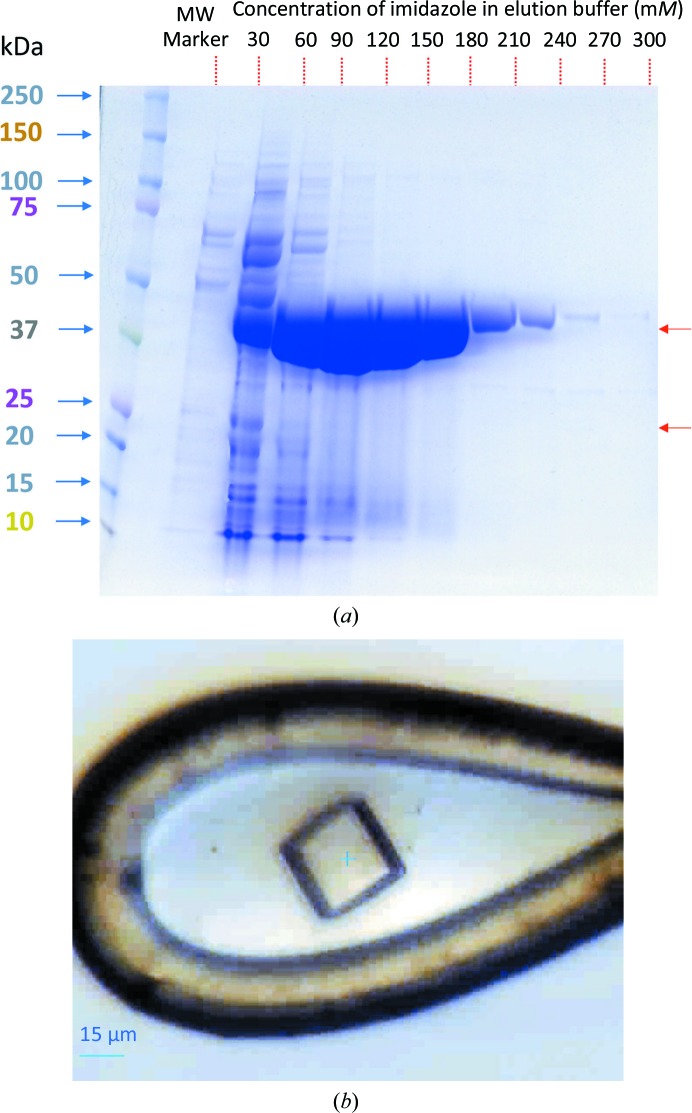
Protein production and crystallization. (a) SDS–PAGE analysis of the amidase elution fractions showing a trace amount of a contaminant which possibly contains EcDSCD. Fractions showing a purity of greater than 95% (120–300 mM imidazole) were pooled and further concentrated to 254 mg ml−1 as measured by the absorbance at 280 nm. The molecular weight of the His-tagged amidase is 47.3 kDa. The concentration of EcDSCD (the crystallized impurity) is roughly estimated as <0.1–0.2 mg ml−1 in a 10× concentrated amidase solution based on a band with a molecular weight of 26 kDa (we speculate that it is the band visible in the 30 mM imidazole elution lane). Red arrows show the approximate locations of the uncleaved and cleaved transferase based on molecular weights of 44 and 26 kDa, respectively. The image was analysed using ImageJ v.1.51j8 (https://imagej.nih.gov/ij/) to estimate the concentrations of total impurities and of EcDSCD. (b) A crystal of EcDSCD as mounted on a cryo-loop at the beamline. The crystal is roughly 35 × 35 × 30 µm in size.